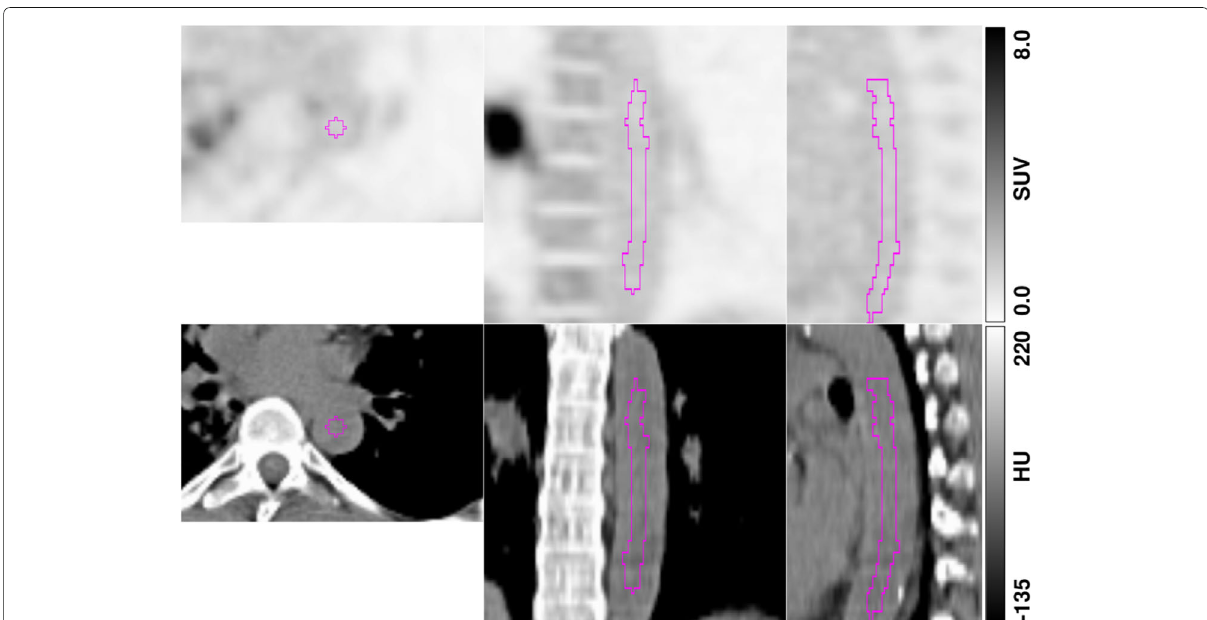
Fig. 1 Example of aorta ROI delineation (top, PET; bottom, CT). Delineation was performed in the transaxial CT slices and transferred to the PET image volume. Shown are orthogonal slices through the 3D-ROI (magenta line)